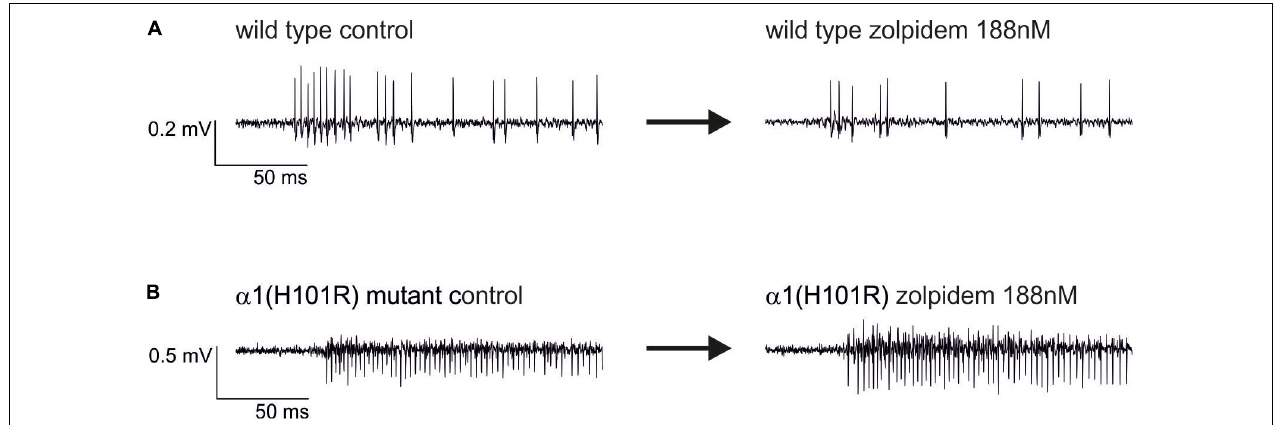
FIGURE 4 | Original extracellular recordings from neocortical cultures of wild type (A) and α 1(H101R) mutant mice (B) under control conditions (left traces) and in the additional presence of 188 nM zolpidem (right traces). The depression of spontaneous neuronal activity by zolpidem right after the onset of the up state is more pronounced in the wild